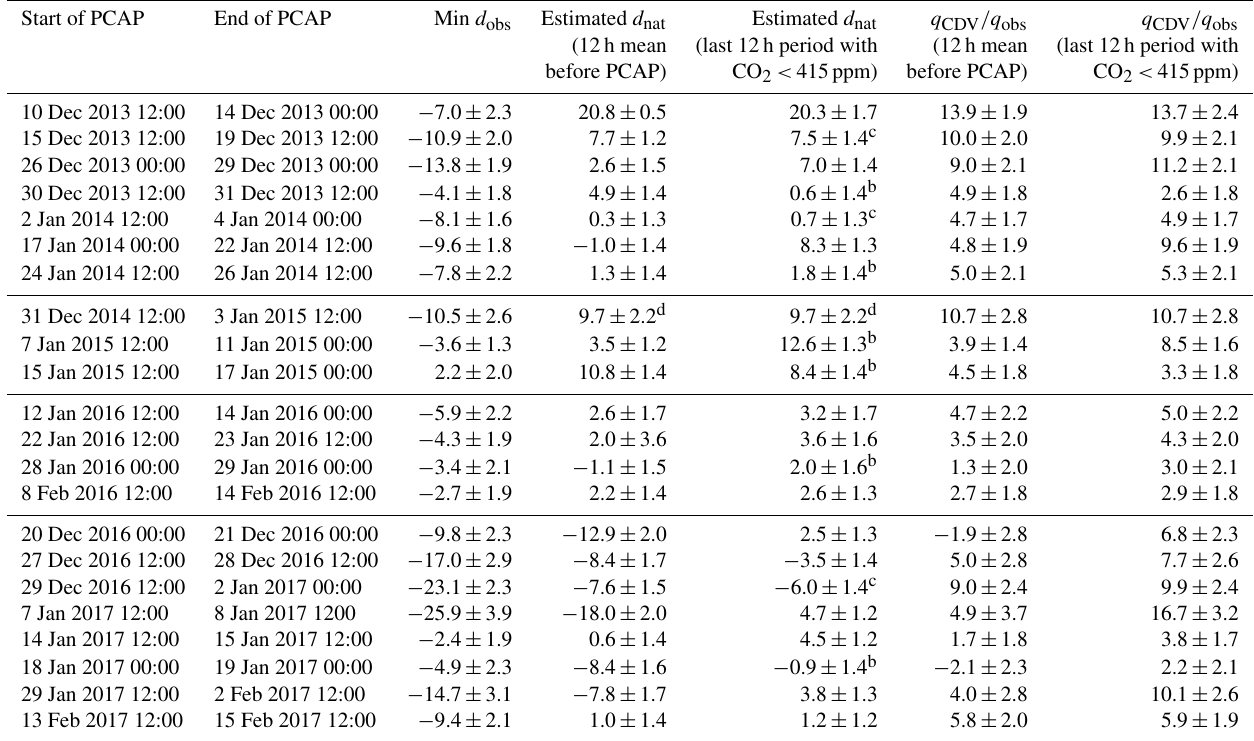
Table 4. Estimates of CDV humidity